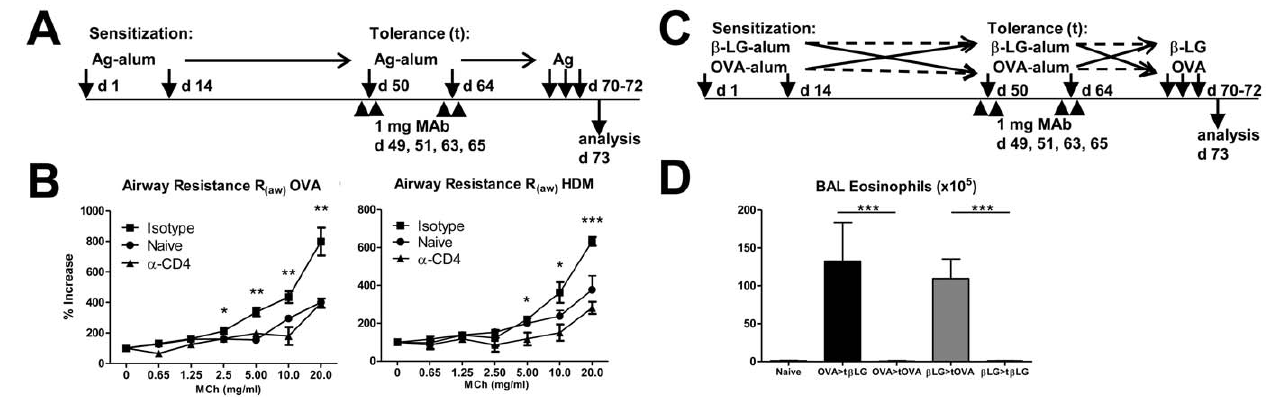
Figure 4. Tolerogenic effect of anti-CD4 treatment is antigen-specific and effective in sensitized animals. (A) BALB/c mice sensitized with OVA-alum or HDM-alum were tolerized to the same antigens on days 50 and 64, and challenged i.n. with the same antigens. (B) Sensitized mice subsequently treated with OVA or HDM under the cover of anti-CD4 showed protection from AHR (n=8 for OVA, n=6 to HDM). Data are representative of two independent experiments. (C) Mice were initially sensitized with OVA-alum or b -LG-alum, and tolerized to the same or a different antigen on days 50 and 64. All mice were challenged i.n. with the same antigen used for initial sensitization. (D) Mice treated with a different antigen together with anti-CD4 did not show reduced BAL eosinophilia (OVA . t b -LG and b -LG . tOVA) while treatment with anti-CD4 and the same antigen used for sensitization showed a significant reduction of BAL eosinophilia (OVA . tOVA and b -LG . t b -LG; n=6, *** P , 0.001). Data are representative of two independent experiments.